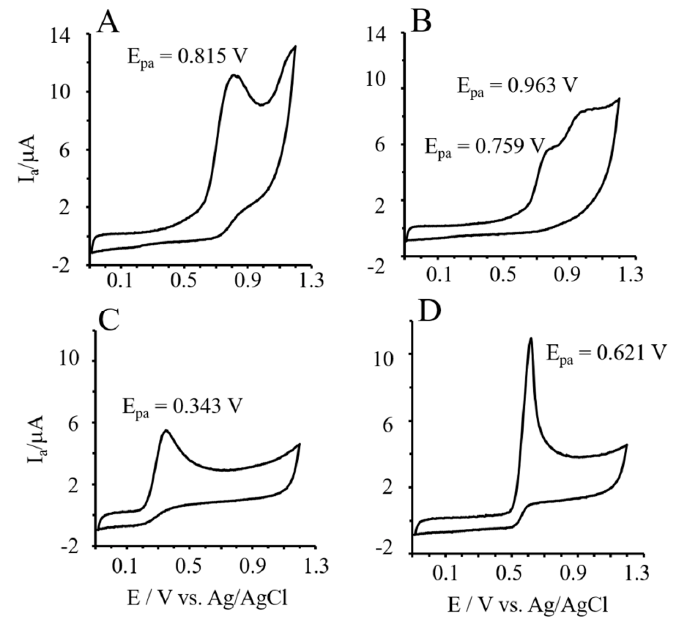
Figure 5. Cyclic voltammograms of 0.25 mM of standards solution (final concentration) of phloretin ( A ), phloridzin ( B ), L-ascorbic ( C ) and uric acid ( D ) in Britton–Robinson (B–R) buffer (0,1 M; pH 7,4) recorded from − 100 to +1300 mV; scan rate 100 mV s − 1 .